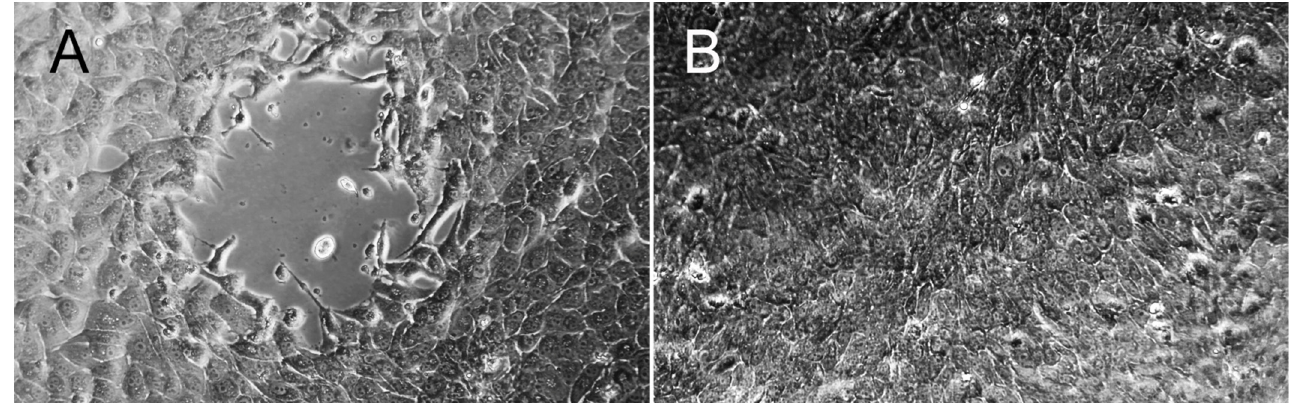
Figure 6. BoPyV-1 isolation in MDBK cells. ( A ) Cytopathic effect after 96 hours of incubation is characterized by cytoplasmic vacuolation and lysis with loss of the monolayer (center) in infected MDBK cells. ( B ) In the negative control, uninfected MDBK cells form a continuous monolayer. Original magnifications 200 ×